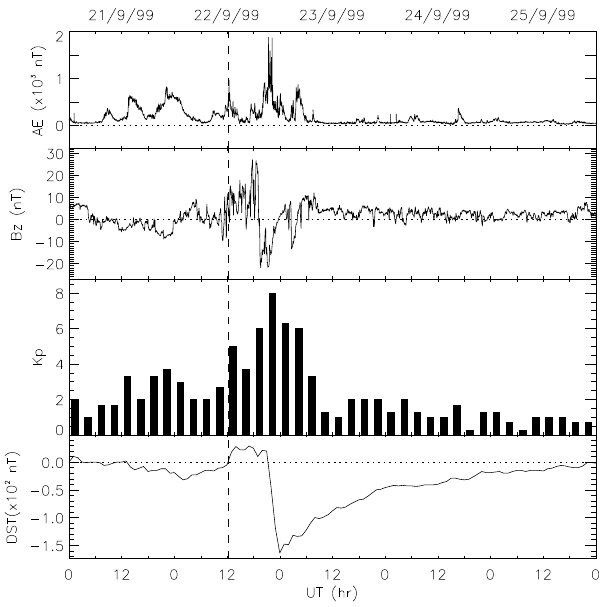
Fig. 2. Variation of geomagnetic indices: AE -index, IMF B z -component, D st and K p indices are shown from top to bottom panels, respectively. The vertical broken line depicts the Storm Sud- den Commencement (SSC) of the 22 September storm.